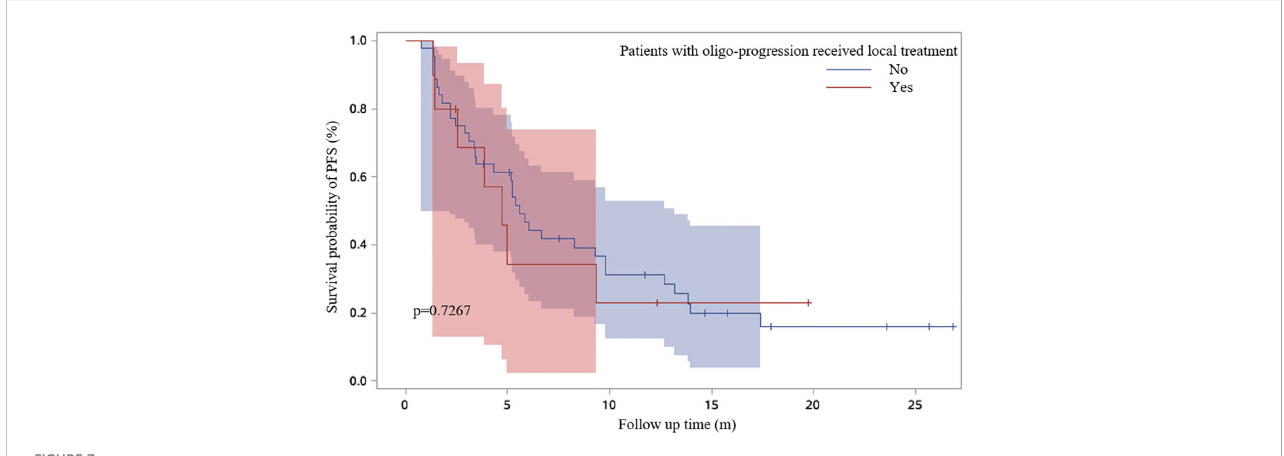
FIGURE 7 Survival curves based on Kaplan-Meier for whether or not patients with oligo-progression received local treatment.